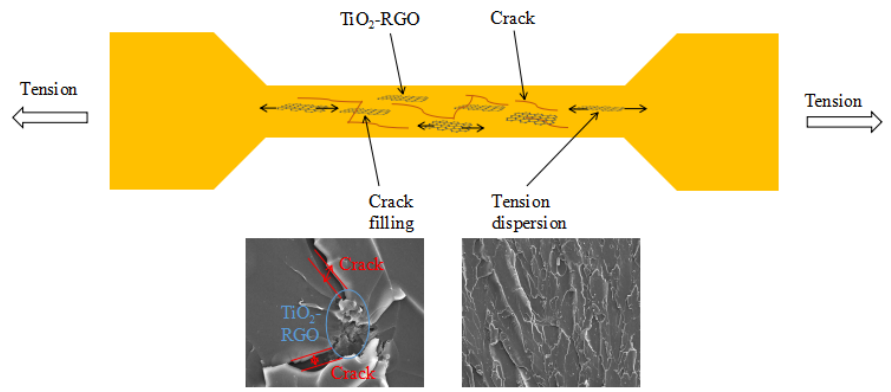
Figure 10. Strengthening mechanism of TiO 2 -RGO nanocomposites on the tensile test of EP.